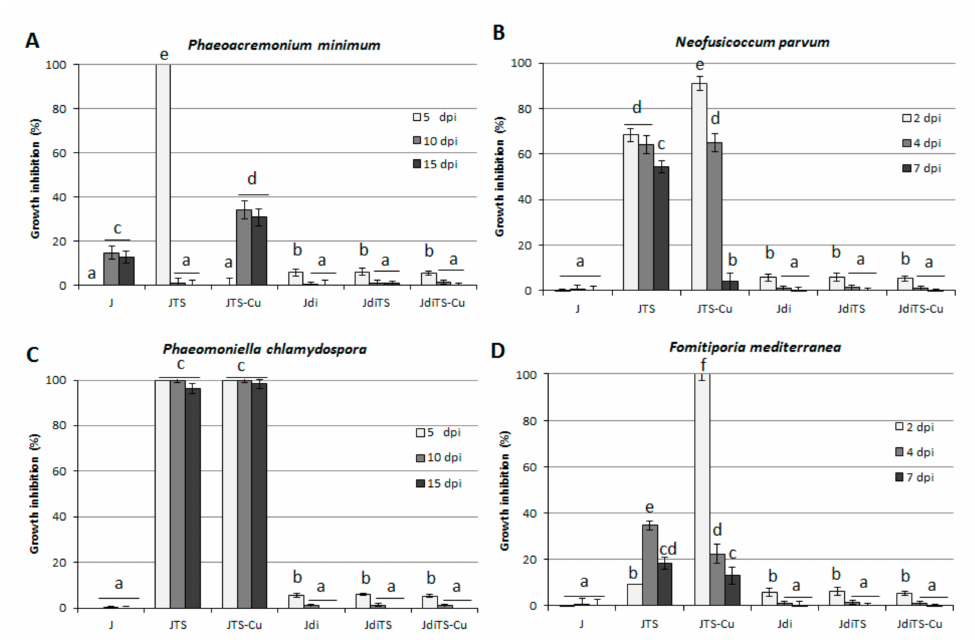
Figure 3. E ff ect of compounds on the growth of esca disease-linked species ( A ) P. minimum , ( B ) N. parvum , ( C ) P. chlamydospora and ( D ) F. mediterranea . Culture medium was amended with molecules at 25 µ M concentration; values are reported as inhibition percentage as compared to the control (Dimethyl sulfoxide, DMSO, 0.25% v / v amended cultures) ± S.D. Di ff erent letters indicate statistically significant di ff erences ( p <